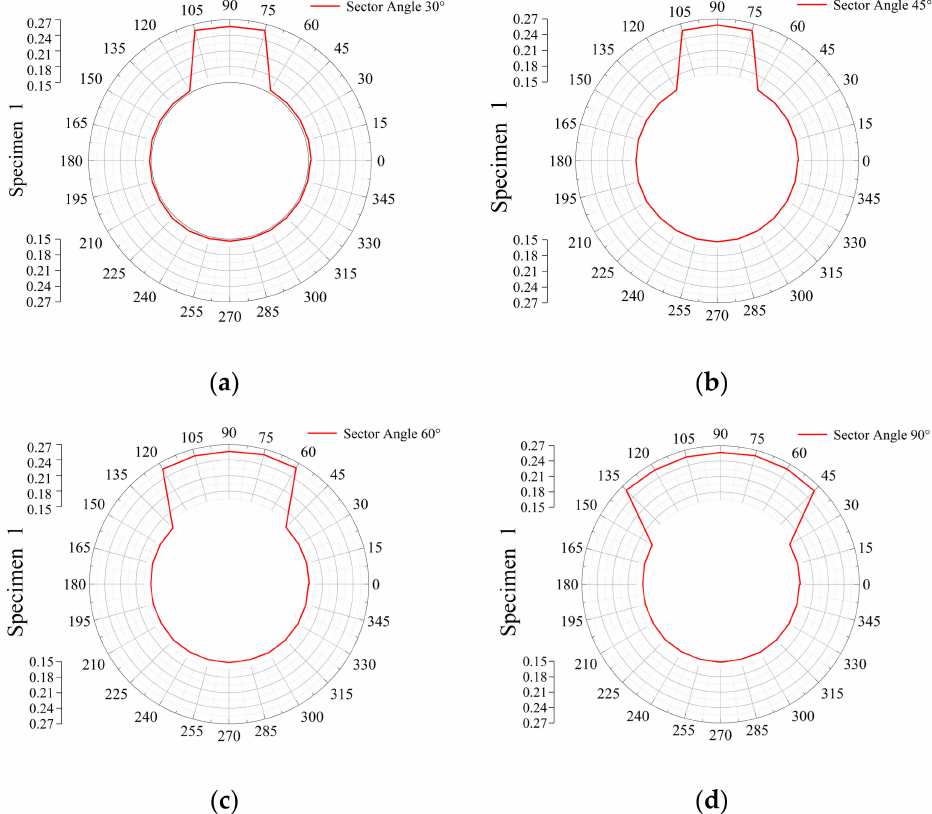
Figure 15. Calculation results of frequency interval of specimen 1. ( a ) Sector angle 30 ◦ . ( b ) Sector angle 45 ◦ . ( c ) Sector angle 60 ◦ . ( d ) Sector angle 90 ◦